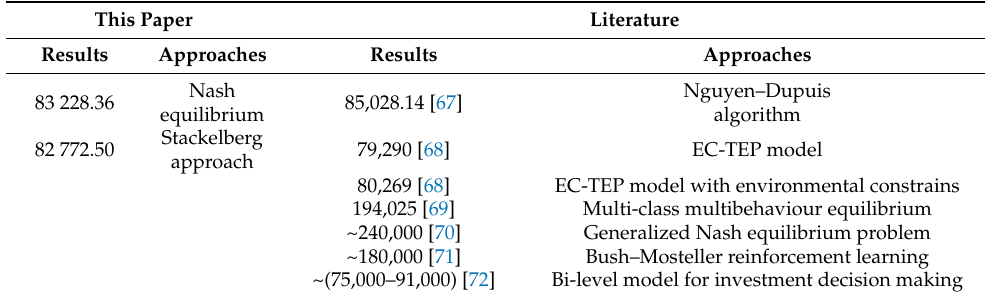
Table 12. Results of optimization on the Nash and Stackelberg approaches in the Nguyen–Dupuis network.